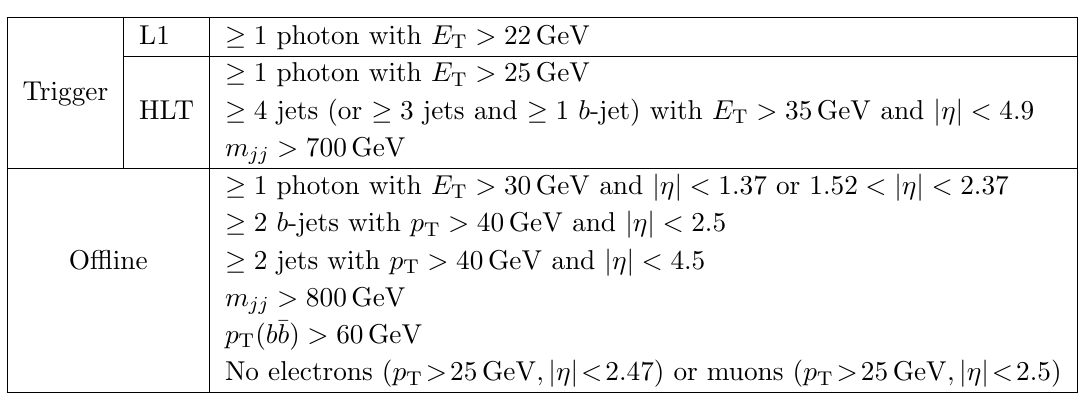
Table 1 . Trigger and o(cid:15)ine event selection criteria for the H ( ! b (cid:22) b ) (cid:13)jj signature. L1 and HLT refer to the (cid:12)rst-level trigger and the high-level trigger,